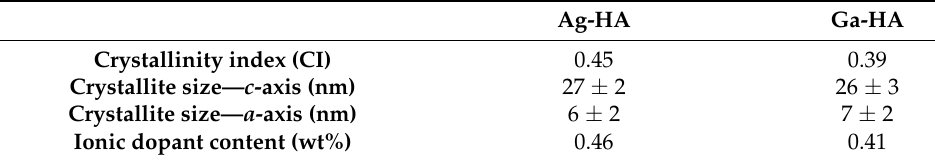
Table 1. Parameters of the obtained HA